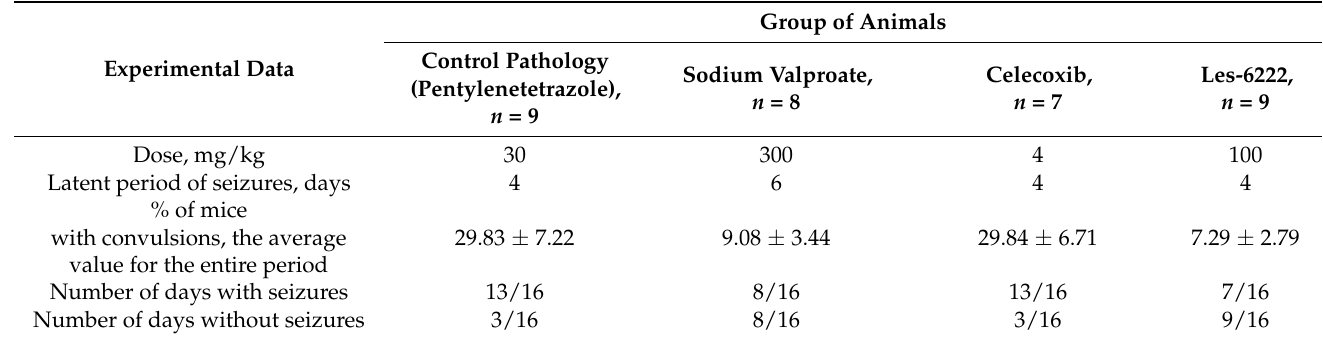
Table 1. Effects of the Les-6222, sodium valproate and Celecoxib on the course of pentylenetetrazole kindling in mice (M ± m).